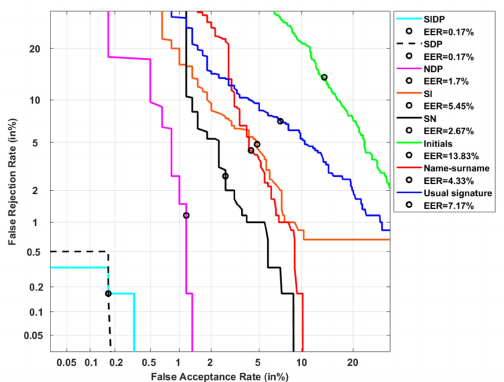
Figure 11. System performance on users of the highest PE category considering the 8 signature